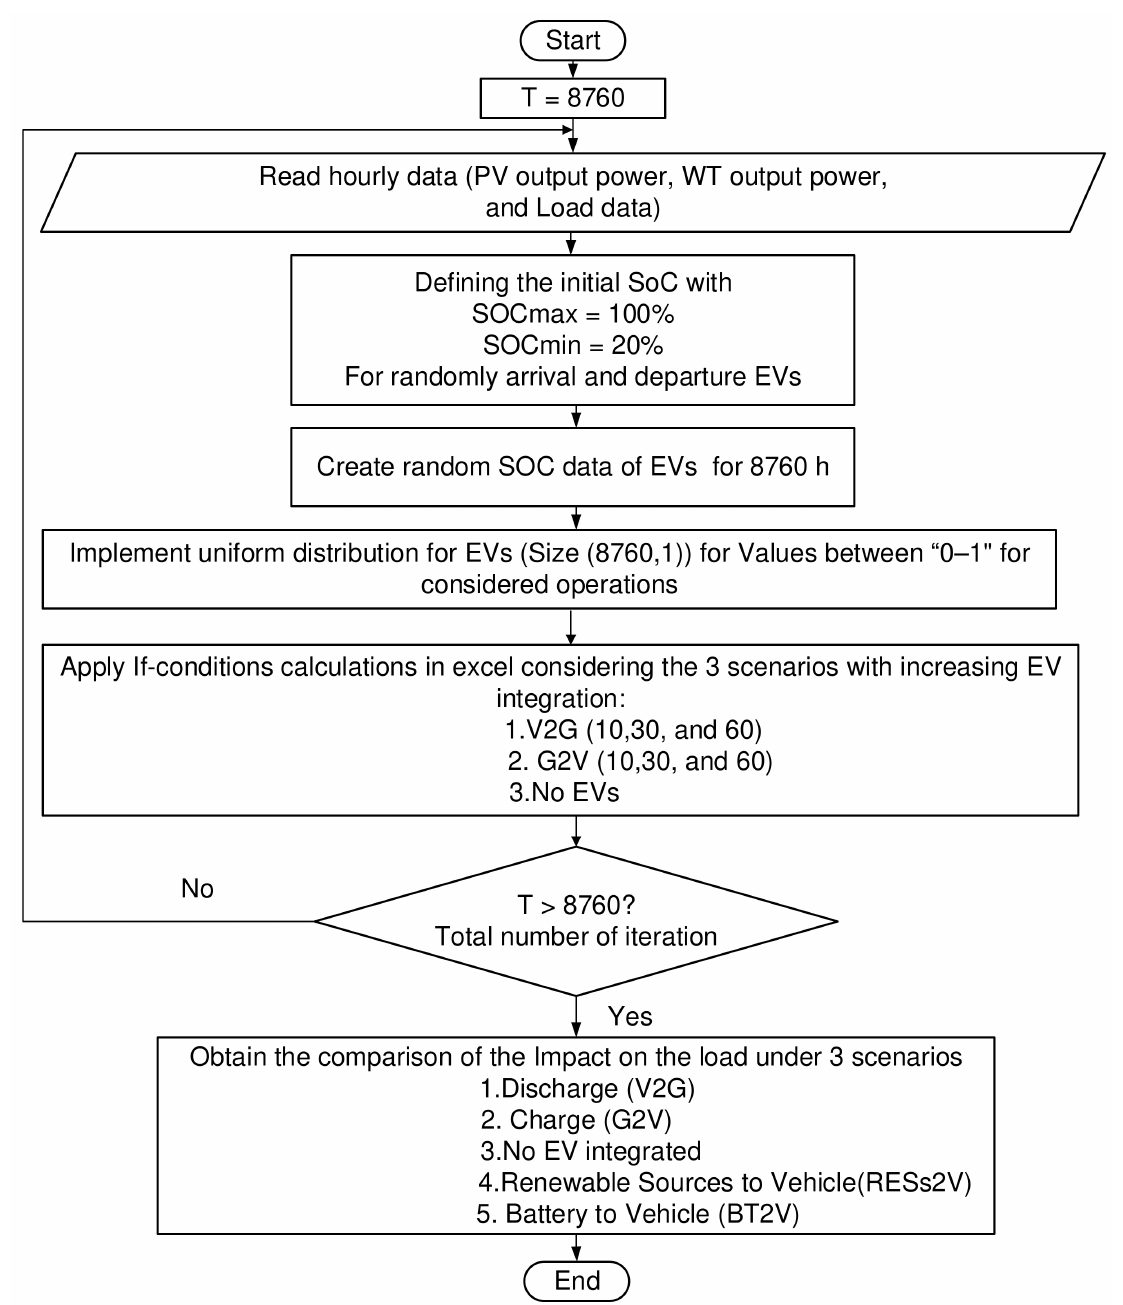
Figure 6. Flowchart of the Vehicle-to-Grid operation using